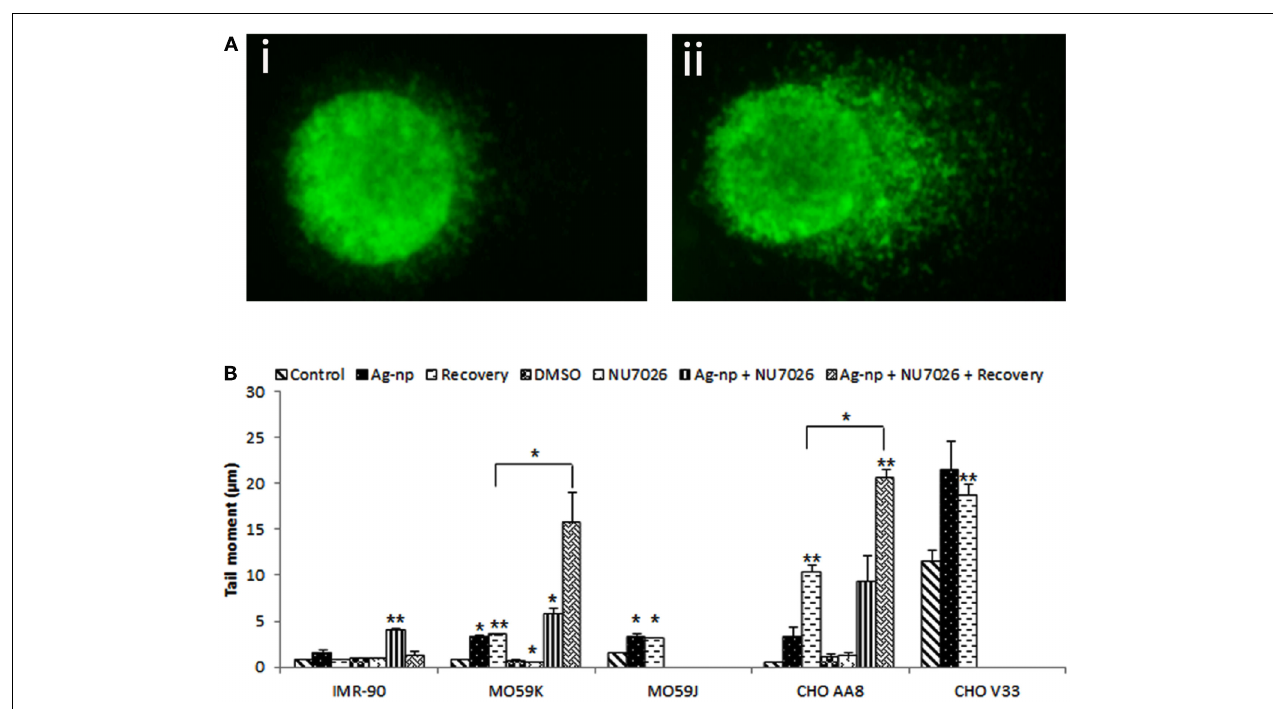
Magnification = 20 × . (B) Mean tail moment ( μ m) represents the damage distribution in the attached cells. Mean ± standard error of three sets of independent experiments are shown. *Denotes p < 0.05 and **denotes p <